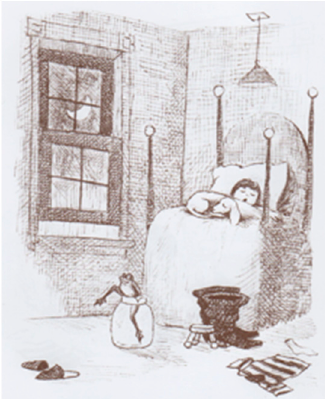
Figure 1. The frog’s ‘journey from the jar’ [1]: There was once a boy who had a dog and a pet frog. He kept the frog in a large jar in his bedroom. One night, while he and his dog were sleeping